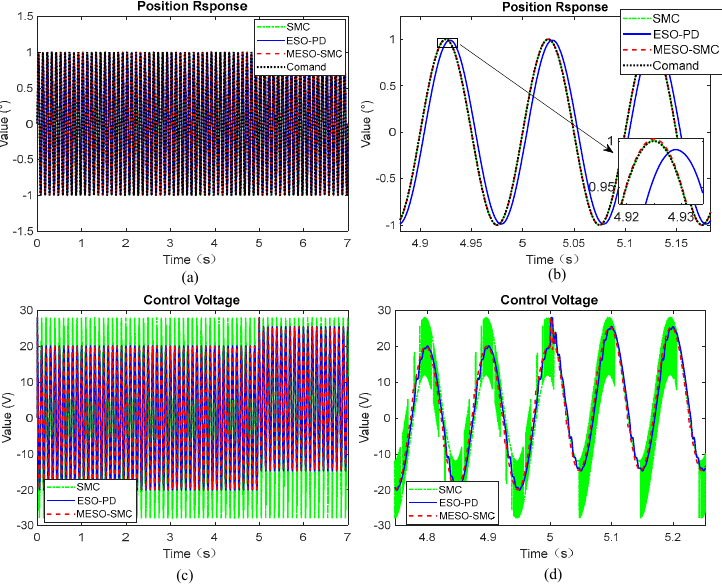
Figure 14. High-frequency dynamic simulation comparisons. ( a ) Position tracking. ( b ) Local curves of ( a ). ( c ) Control voltage. ( d ) Local curves of ( c ).